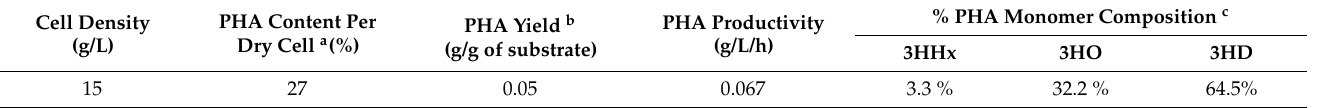
Table 1. Biosynthesis of MCL-PHA during 60-h fed-batch cultivation of Pseudomonas putida . PHA Content Per Cell Density Dry Cell a (%) (g/L)